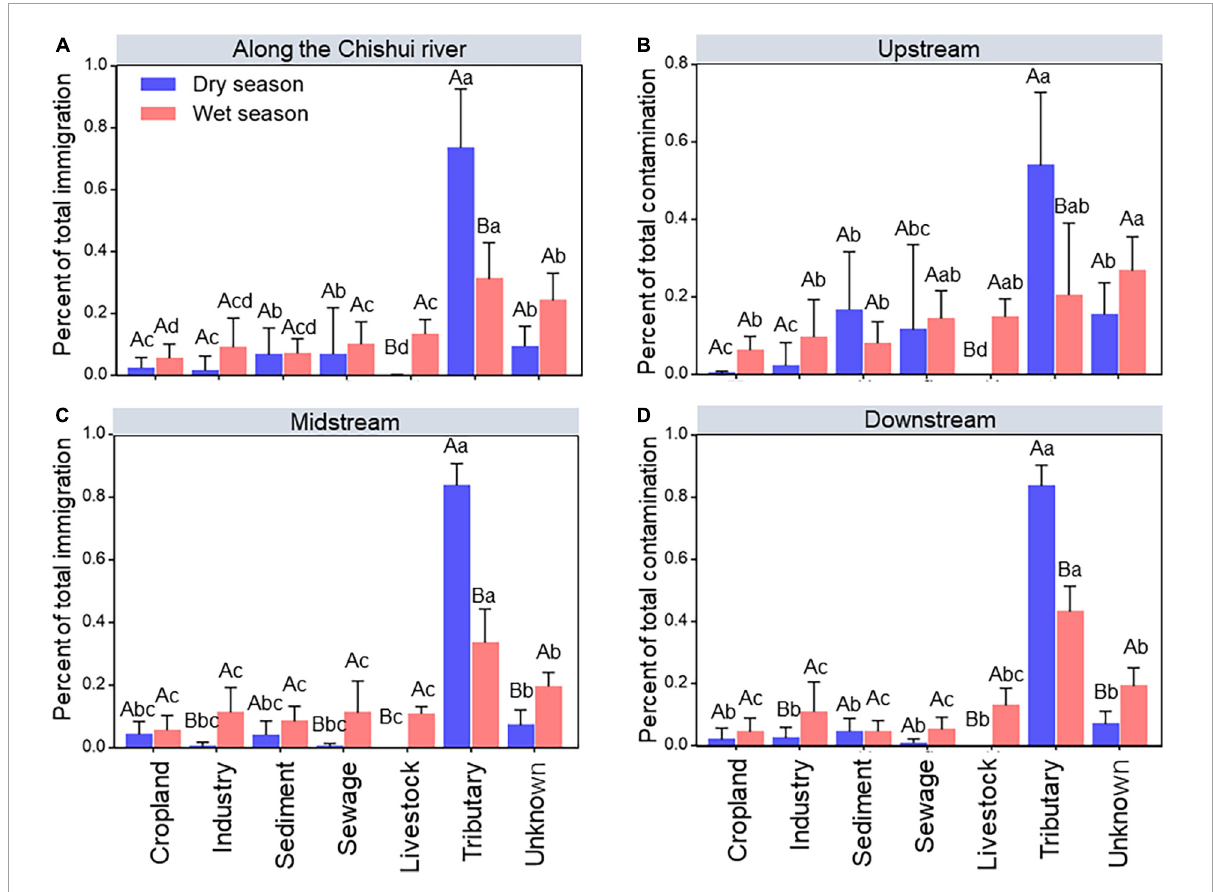
FIGURE2 Source–tracking analysis showing the relative contributions of external immigrations to the overall microbial community at the whole Chishui River scale (A) , and the upstream (B) , midstream (C) , and downstream of the river (D) between the dry and wet season. “Unknown” includes the percentage of contributions not able to be attributed to a specific source. Different capital letters mean a statistical significance ( p < 0.05) between dry and wet seasons within the same river section, and different small letters mean a statistical significance ( p < 0.05) along different river sections within the same